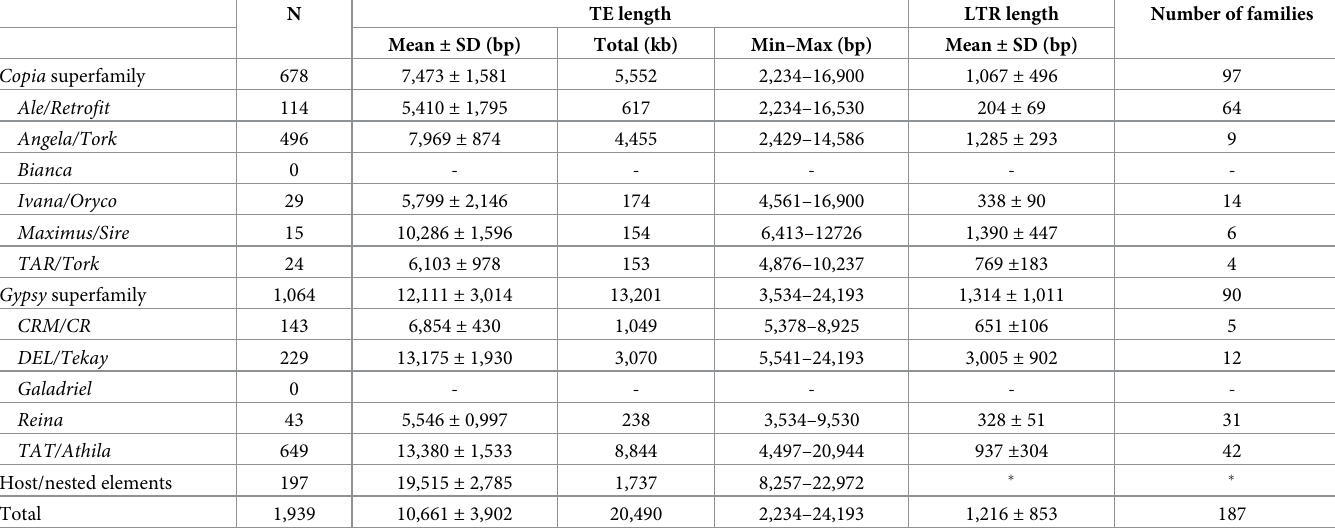
� The LTR length and number of families of the host and nested elements were counted within the corresponding lineage. More details of the host/nested elements can be found in S2